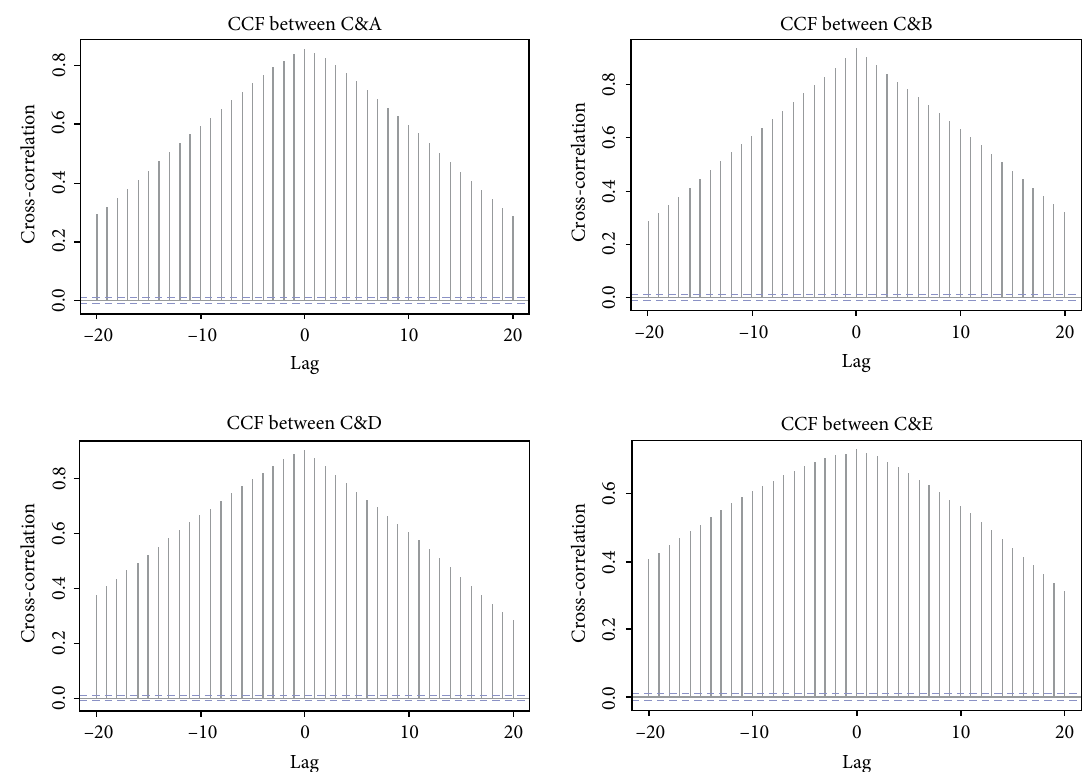
Figure 3: Cross-correlation values of speed between station C and other adjacent